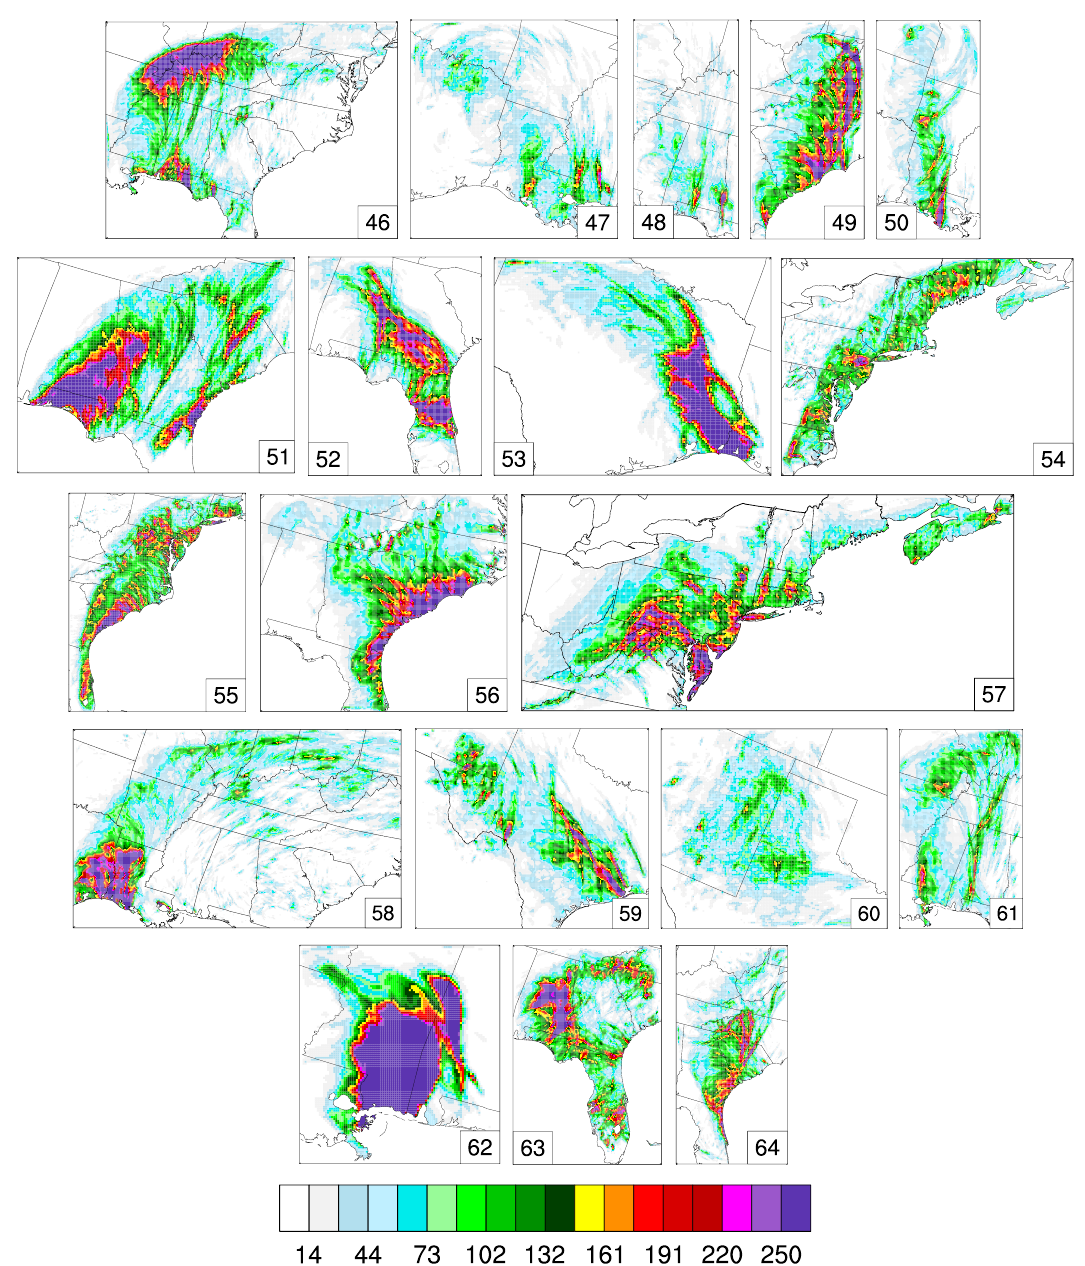
Figure A1. PD (mm) fields in simulation inner domains accumulated between the inner-domain simulation start and end dates provided in Table